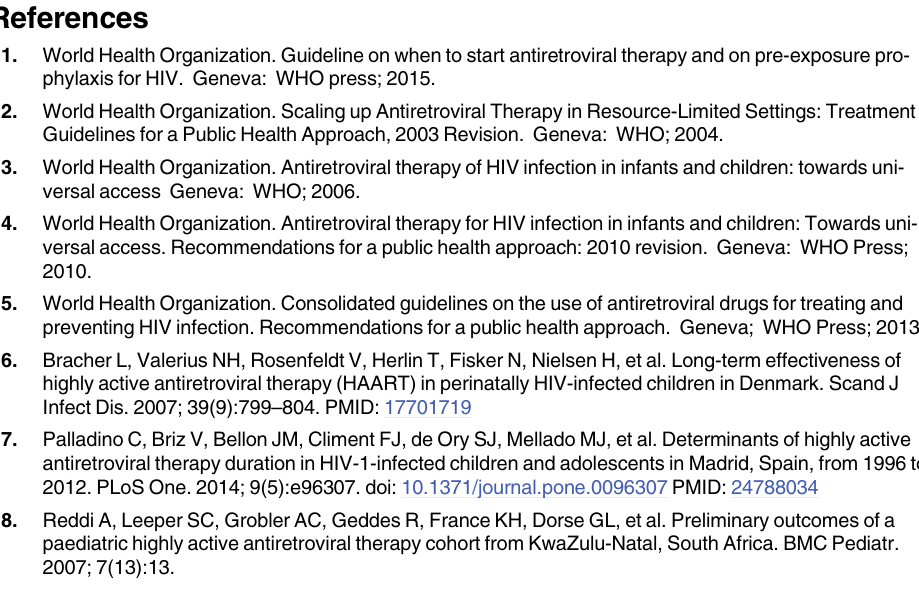
S1 Table. Changes in guidelines for antiretroviral therapy initiation. S2 Table. Changes in the recommended first-line antiretroviral therapy. S3 Table. Reasons for discontinuations by antiretroviral